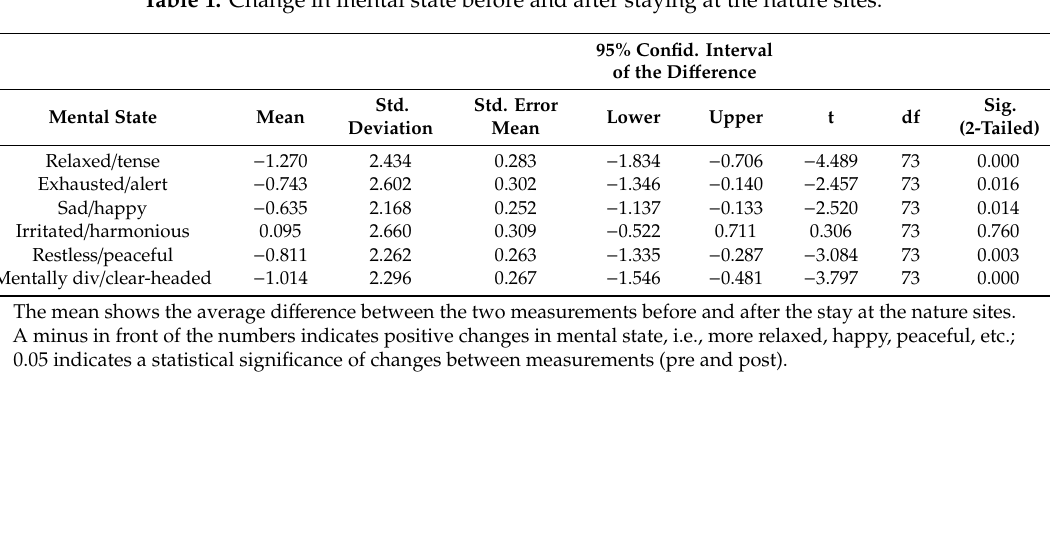
Table 1. Change in mental state before and after staying at the nature